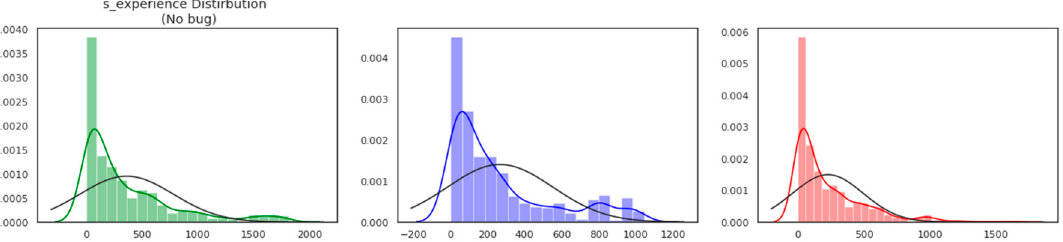
Figure 6. Distribution of exp, rexp and sexp with the target.